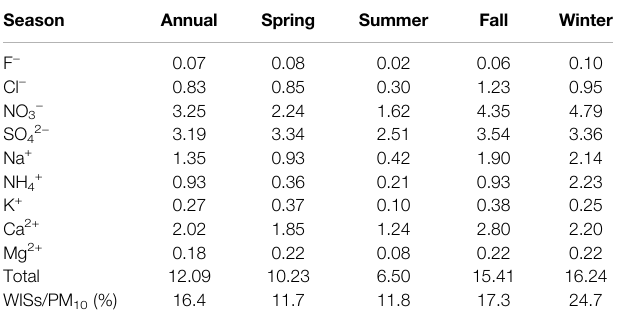
TABLE 2| Seasonaldistributionofwater-solubleionsmassconcentrationsinfour seasons in Jiuquan city during the entire sampling period ( μ g/m 3